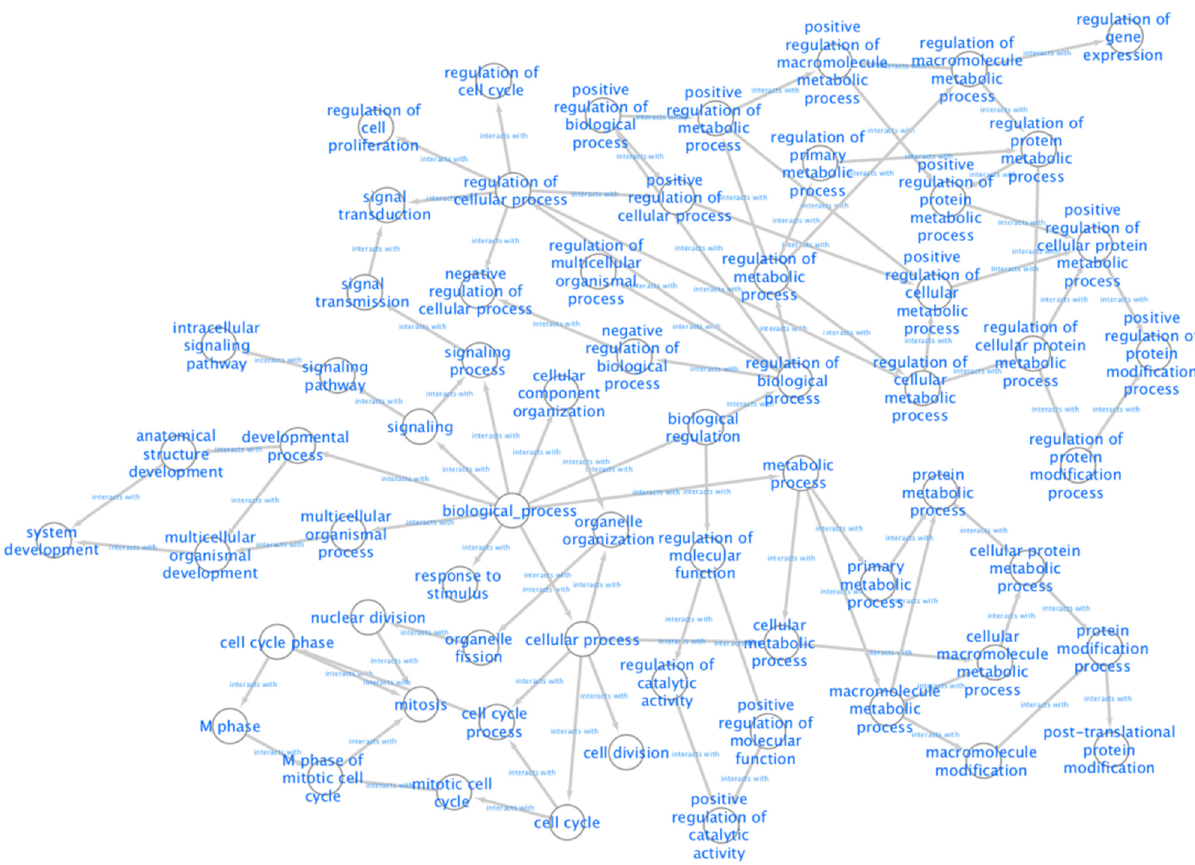
Figure 5: Pathways of enriched BPs according to results of the